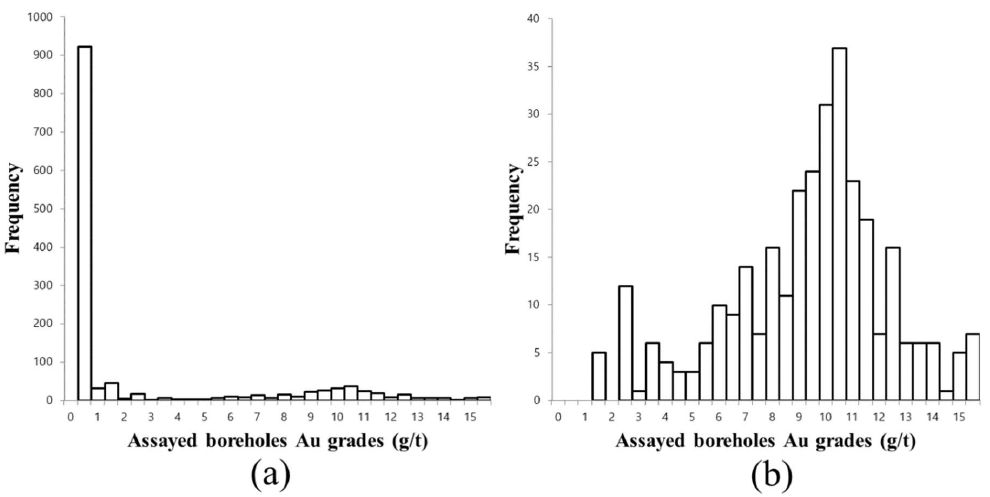
Figure 2. Sample survey of Au grade for ( a ) all data and ( b ) data in quartz vein from boreholes in the Au deposit.